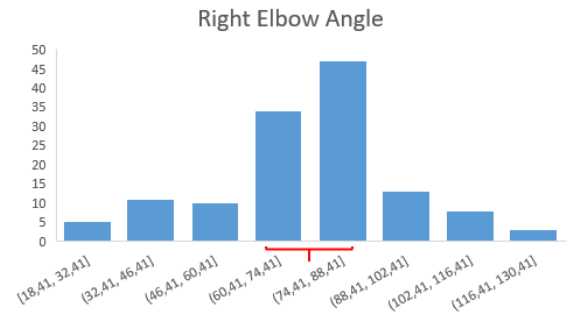
Fig. 7. Histogram of ROM interval for the right elbow flexion, from a single individual, during interaction with the GestureChair application (y- axis: represents how many times a certain range of motion was executed and x-axis: represents the interval in degrees of the range of motion). In Figure 8, the ROM of the left shoulder joint is presented during interaction with the GesturePuzzle VR software, where it is possible to identify a movement of up to approximately 60 degrees of abduction of the shoulder, needed to complete each of the nine pieces of the virtual puzzle. The highlights in red indicate good motor control and faster execution, while the highlights in blue indicate the need for more time to complete the task.